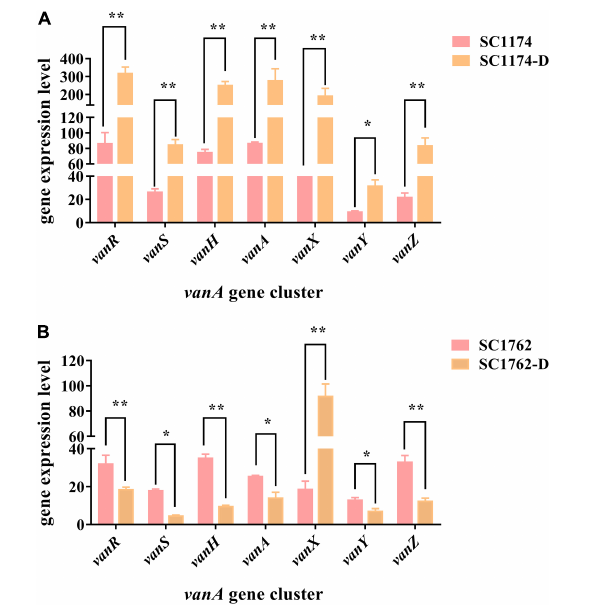
FIGURE 6 | Relative expression levels of the vanA gene cluster in four E. faecium isolates. Expression levels of the vanA gene cluster in the non-CS group (A) and the CS group (B) . Data represent the mean values from three independent experiments with error bars indicating standard deviations, and asterisks denote the significance of differences in expression by the paired Student’s t -test (* P < 0.05 and ** P <